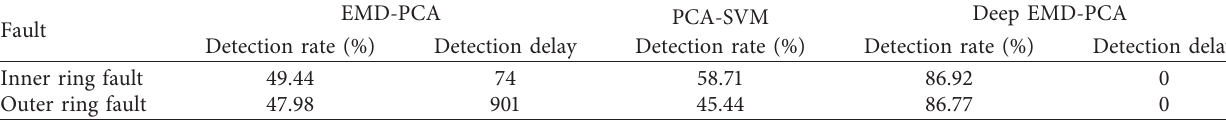
Table 1: Experimental performance comparison of Case Western Reserve University.